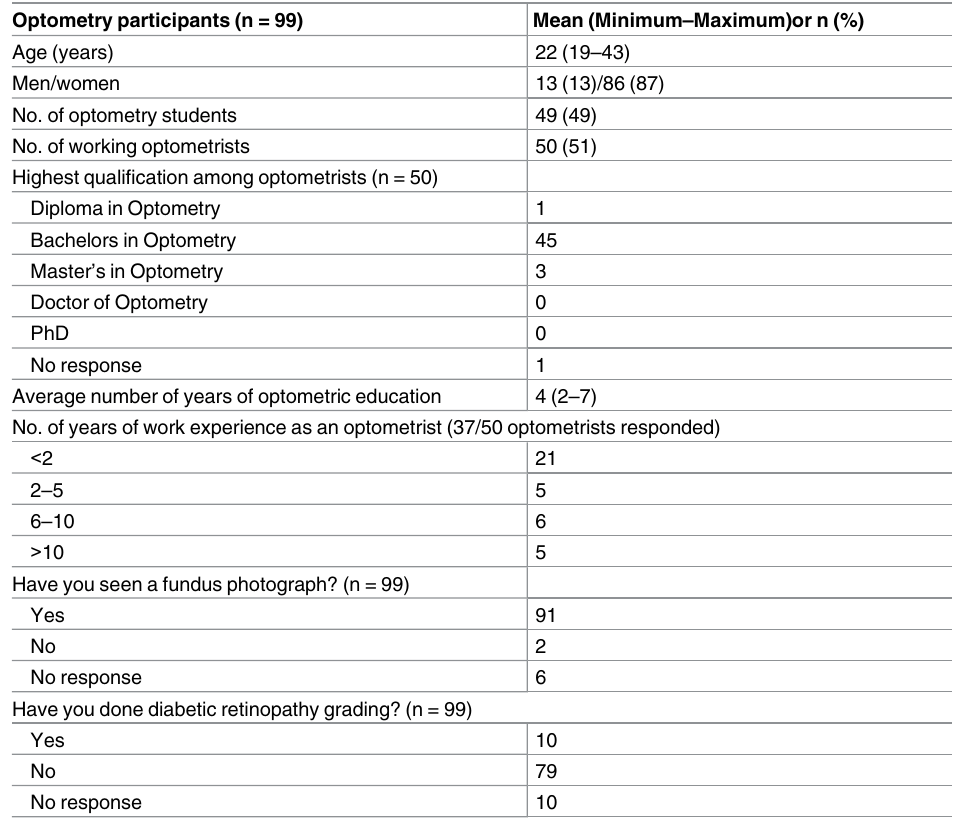
Table 1. Background Details of the